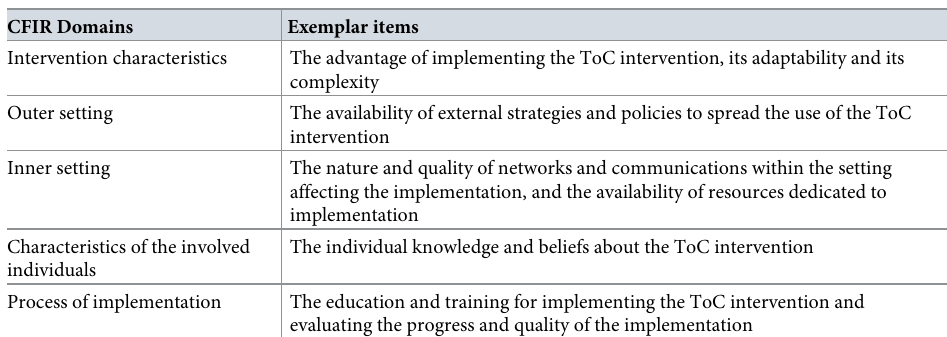
Table 1. The CFIR domains.